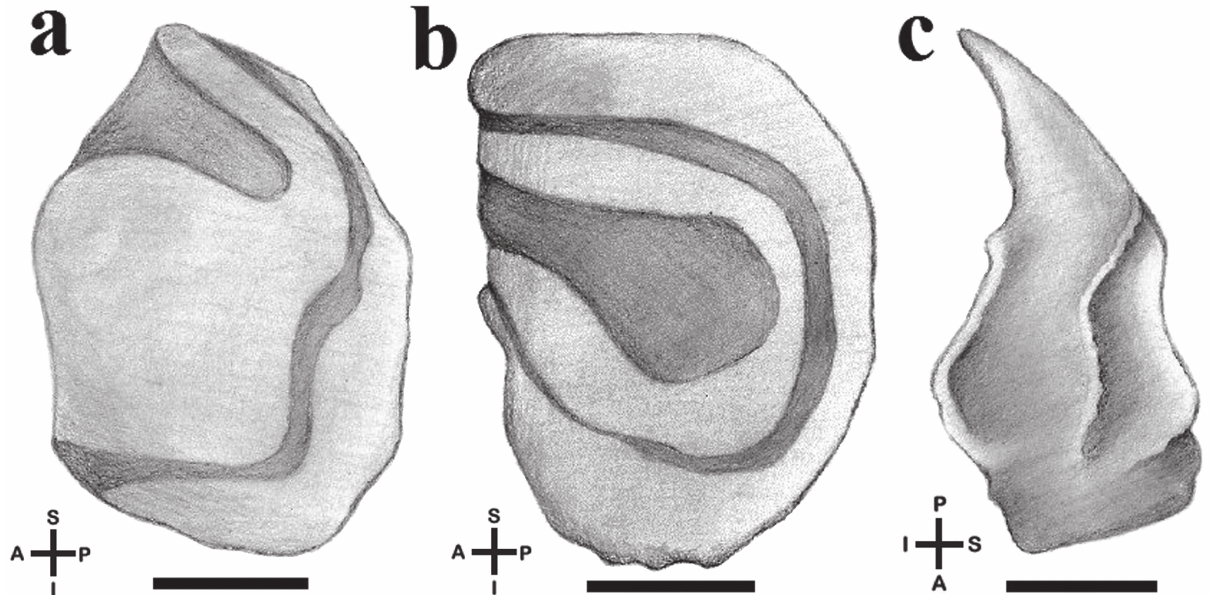
Fig. 4. Right serie of otoliths of Hypoptopoma inexpectatum (a) Lapillus, Scale bar = 200 µm; (b) Asteriscus, Scale bar = 200 µm; (c) Sagitta, Scale bar = 200